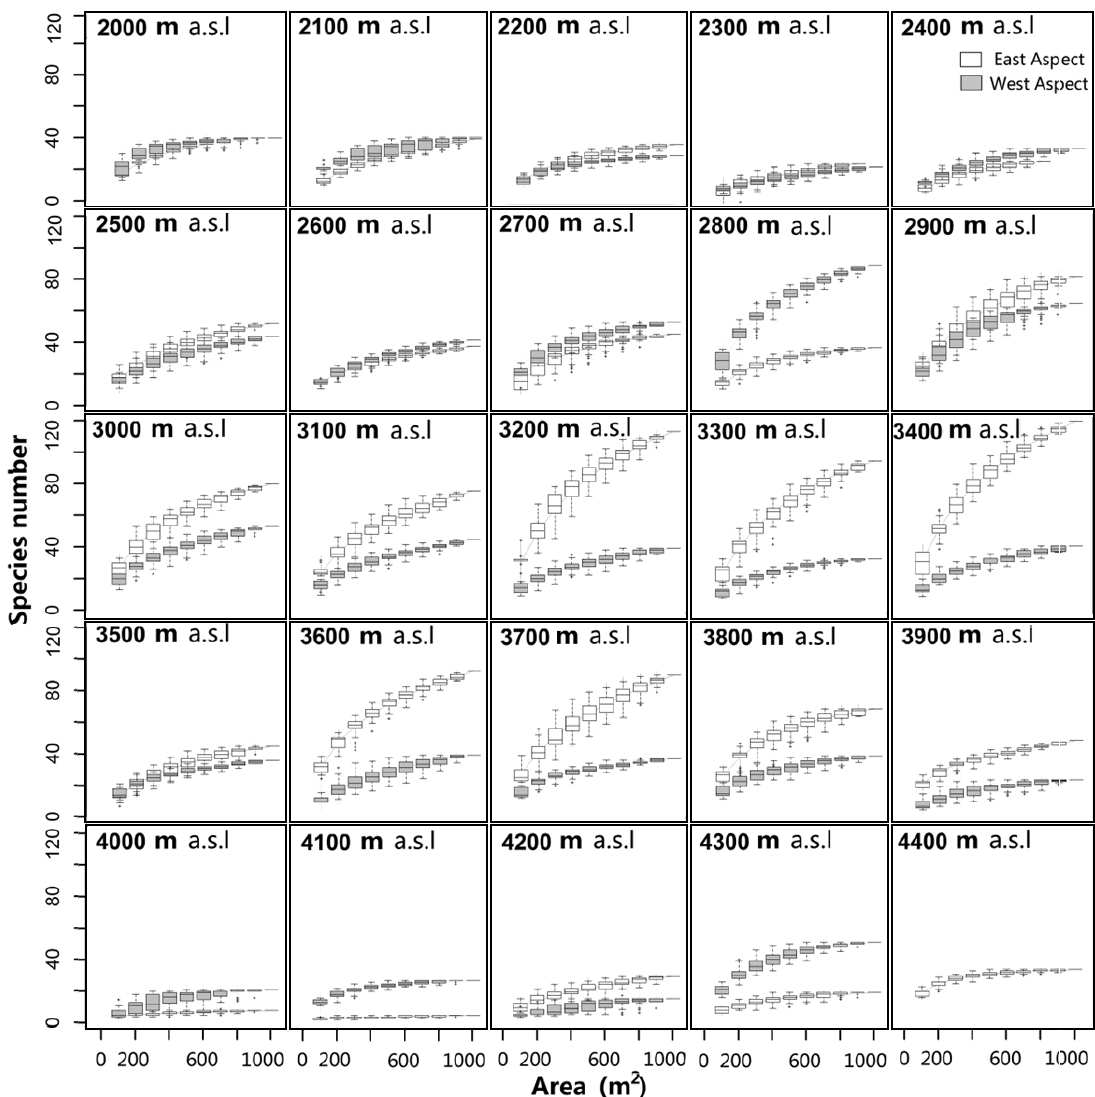
Figure 4. Contrast of species-area curves between pairs of transects along the elevation gradient on eastern and western aspects of Baima Snow Mountain. The horizontal line in each boxplot indicates the median species richness in a specific sampling area at different elevations and aspects and the error bar indicates 2.5 and 97.5 quantiles.